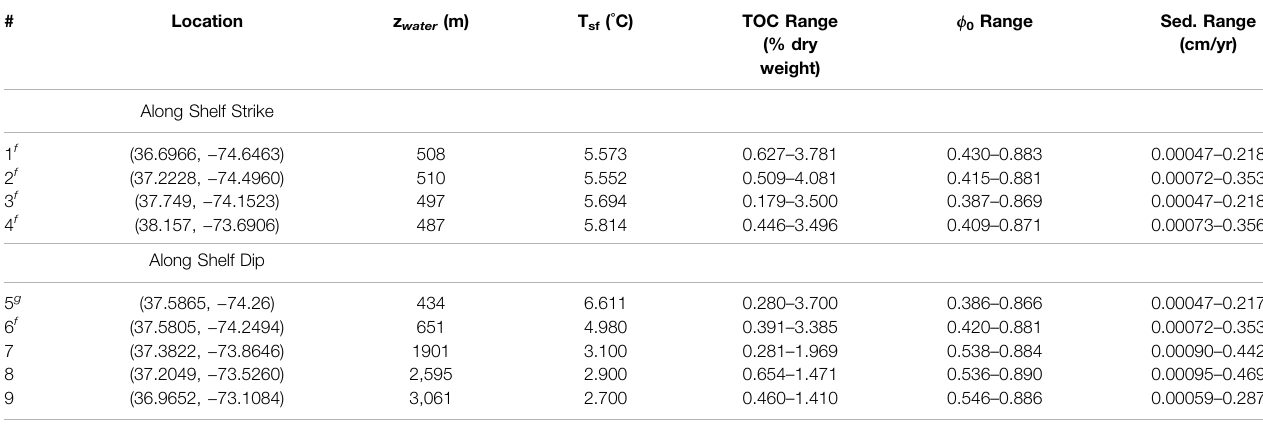
TABLE 3 | Value ranges used in PLFOTRAN/Dakota model (gas locations g and feather edge locations f ). For all locations, heat fl ux ranged from 42.3 – 52.2 mW/m 2